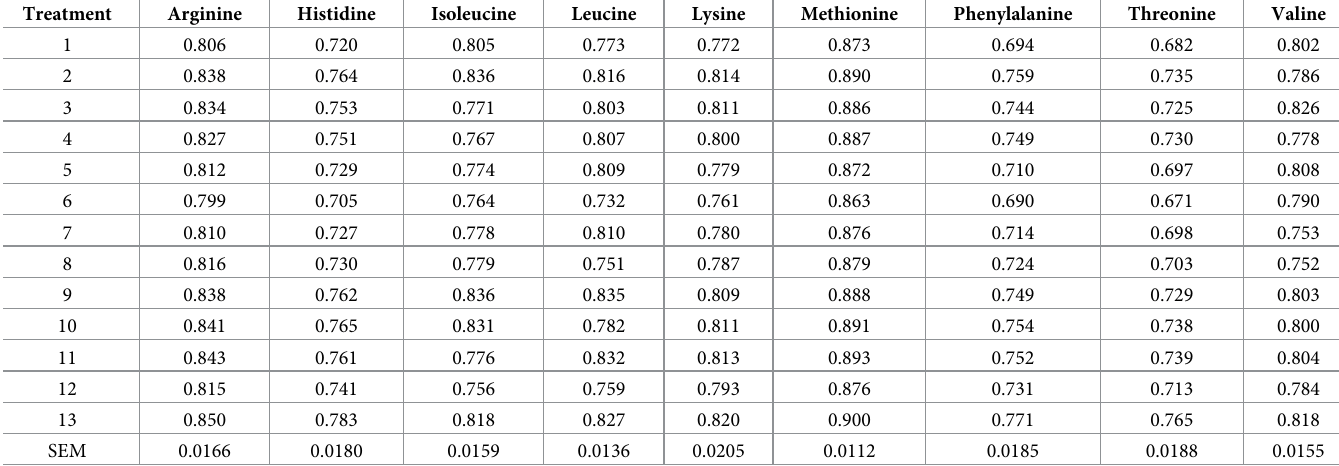
Table 10. Effects of dietary treatments on apparent ileal digestibility coefficients of essential amino acids at 28 days post-hatch. Treatment